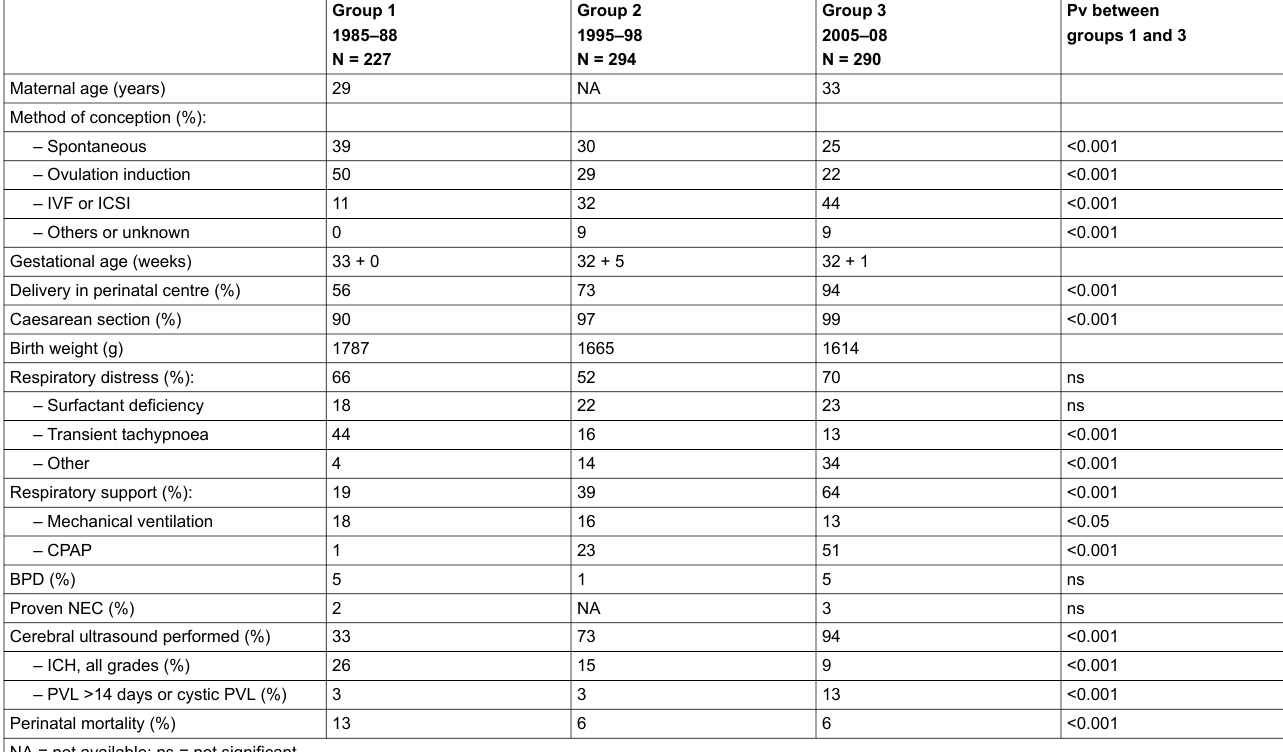
Table 3: Outcome of triplets in the three Swiss national surveys and comparison between the first and the third